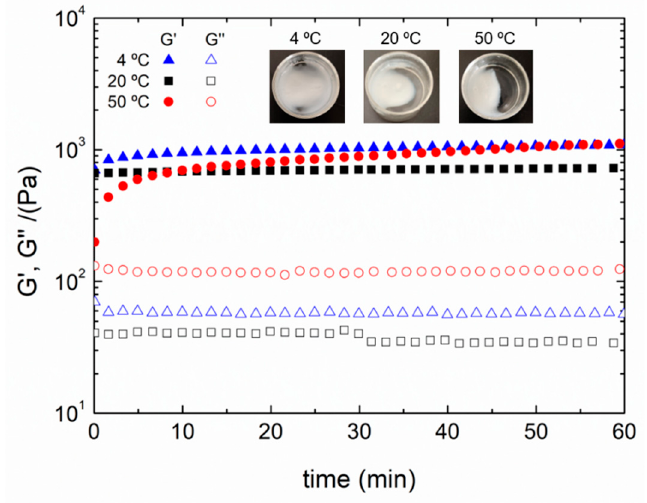
Figure 3. Time tests and macroscopic aspects of chitosan hydrogels processed at different gelation temperatures (4, 20 and 50 °C). The presented data are the mean values for each system.